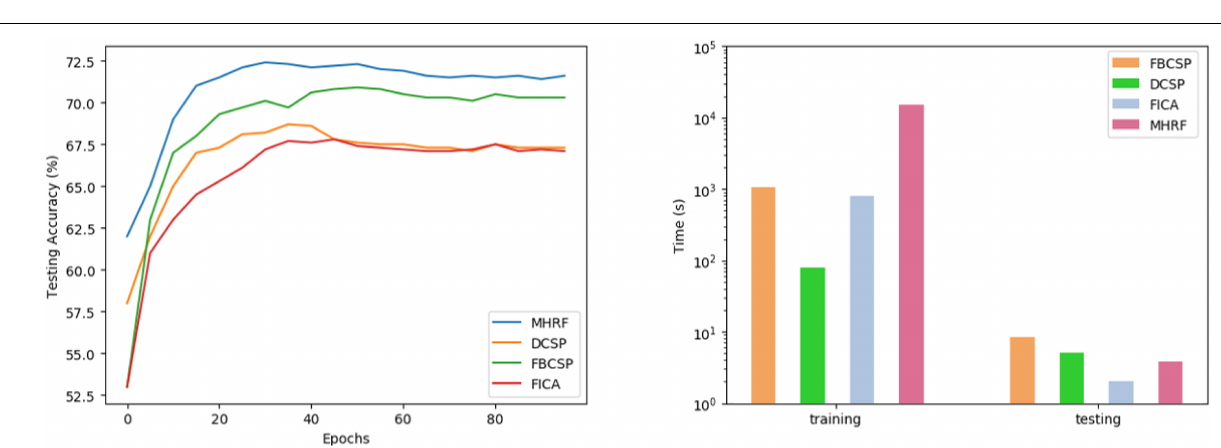
TABLE 3 | Average accuracy of multi-hierarchical representation fusion (MHRF) in cross-validation. Subjects